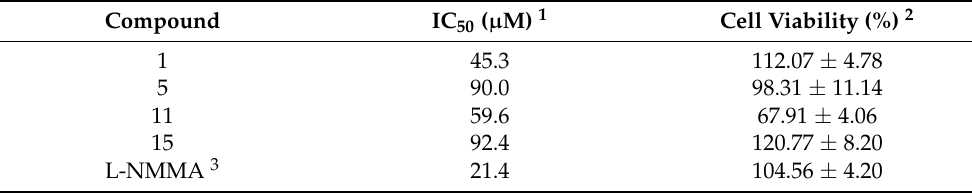
Table 4. Effects of select compounds on NO generation in LPS-stimulated BV-2